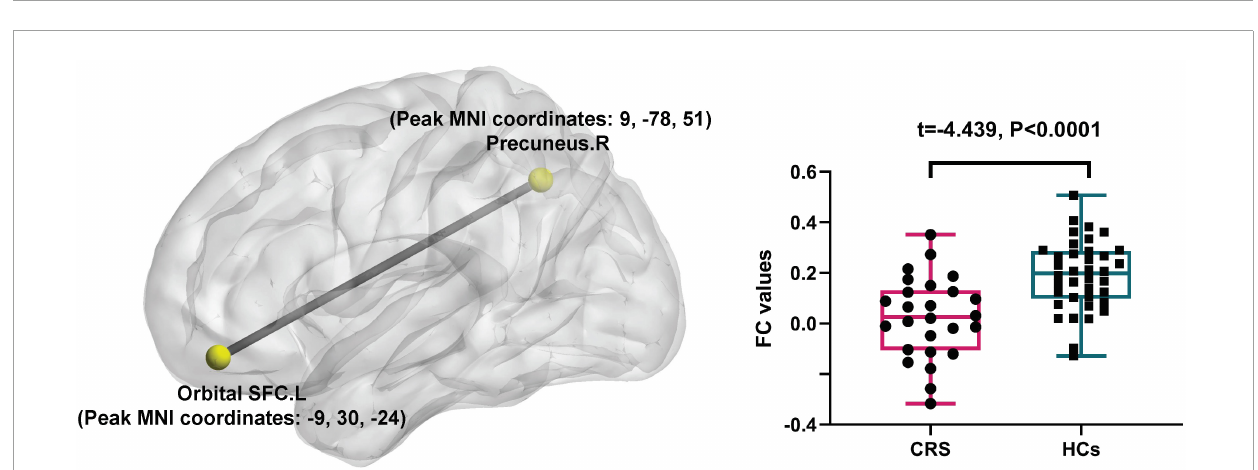
FIGURE2 Seed-based FC differences between CRS patients and HCs ( P < 0.05, FDR corrected). Compared with HCs, patients with CRS showed significantly decreased FC between the seed region in the left orbital superior frontal cortex and the right precuneus. SFC, superior frontal cortex; L, left; R, right.